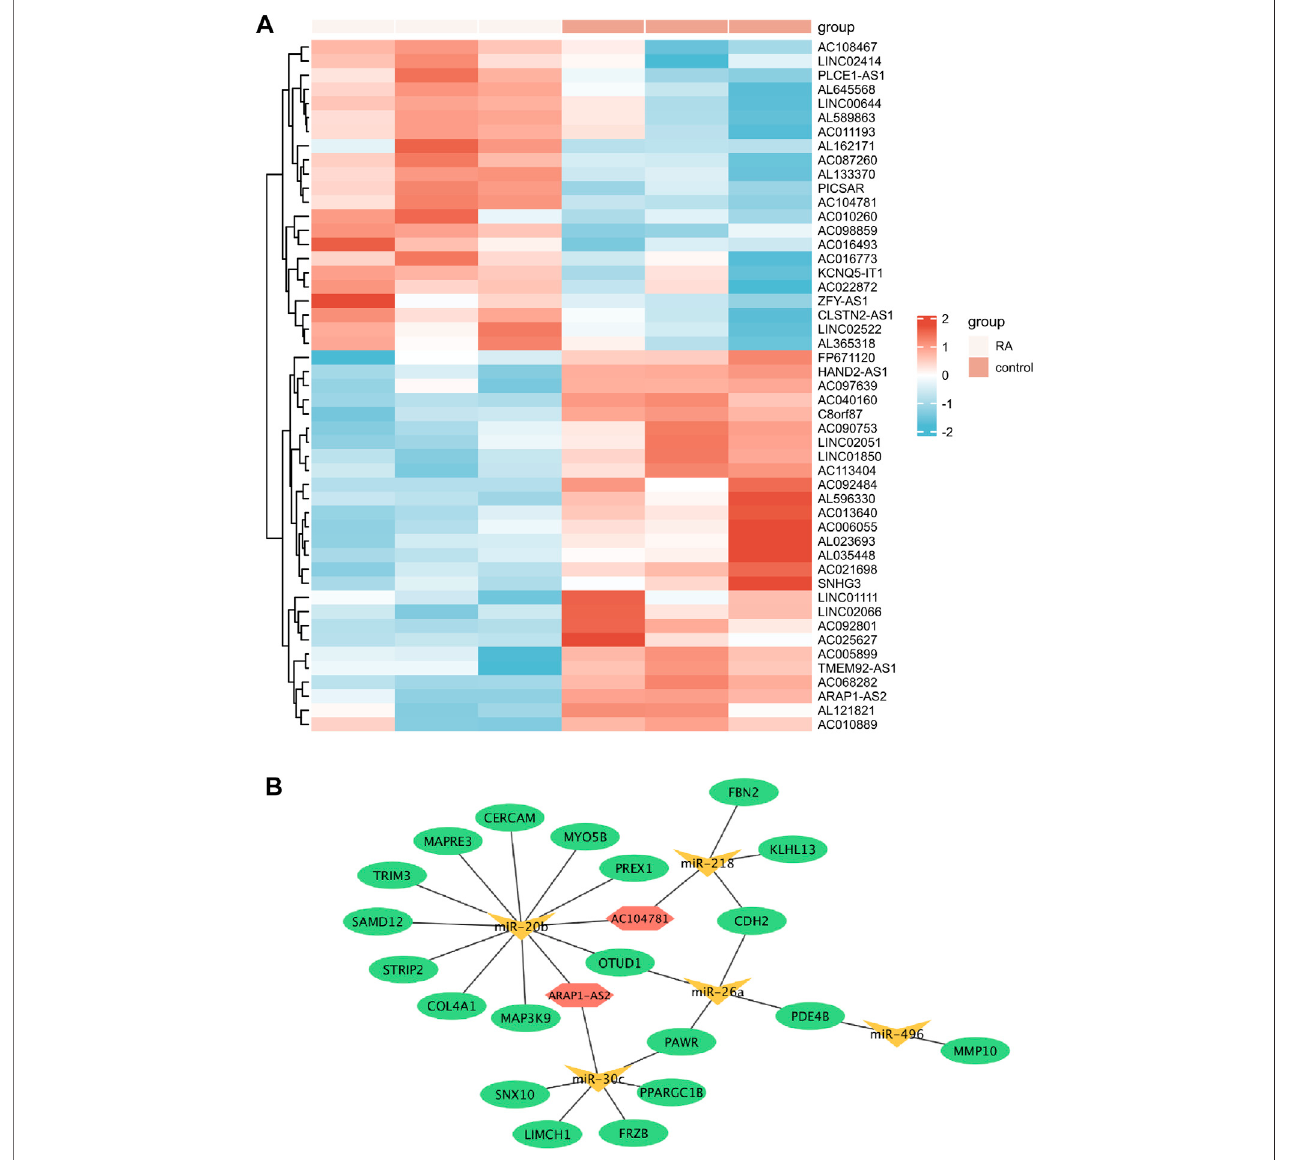
FIGURE6| Identi fi cationofdifferentiallyexpressed lncRNAs(DELs)andEstablishmentoftheceRNAnetwork (A) HeatmapoftheDELs(red:highexpression;blue: low expression) (B) The ceRNA network in Rheumatoid arthritis (RA) (ellipse: mRNA, triangle: miRNA, and hexagonal: lncRNA).